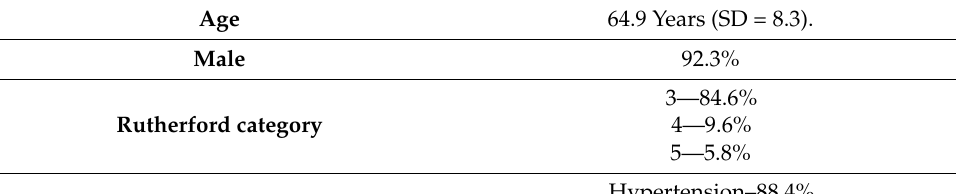
Table 1. Study population and lesion